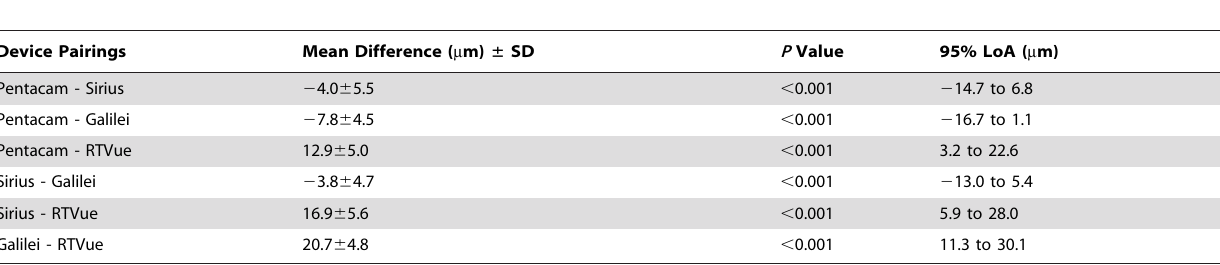
Table 4. Mean difference of superior 2 mm corneal thickness, corresponding results of Bonferroni post hoc comparison and 95% limits of agreement (LoA) among the 4 investigated devices.